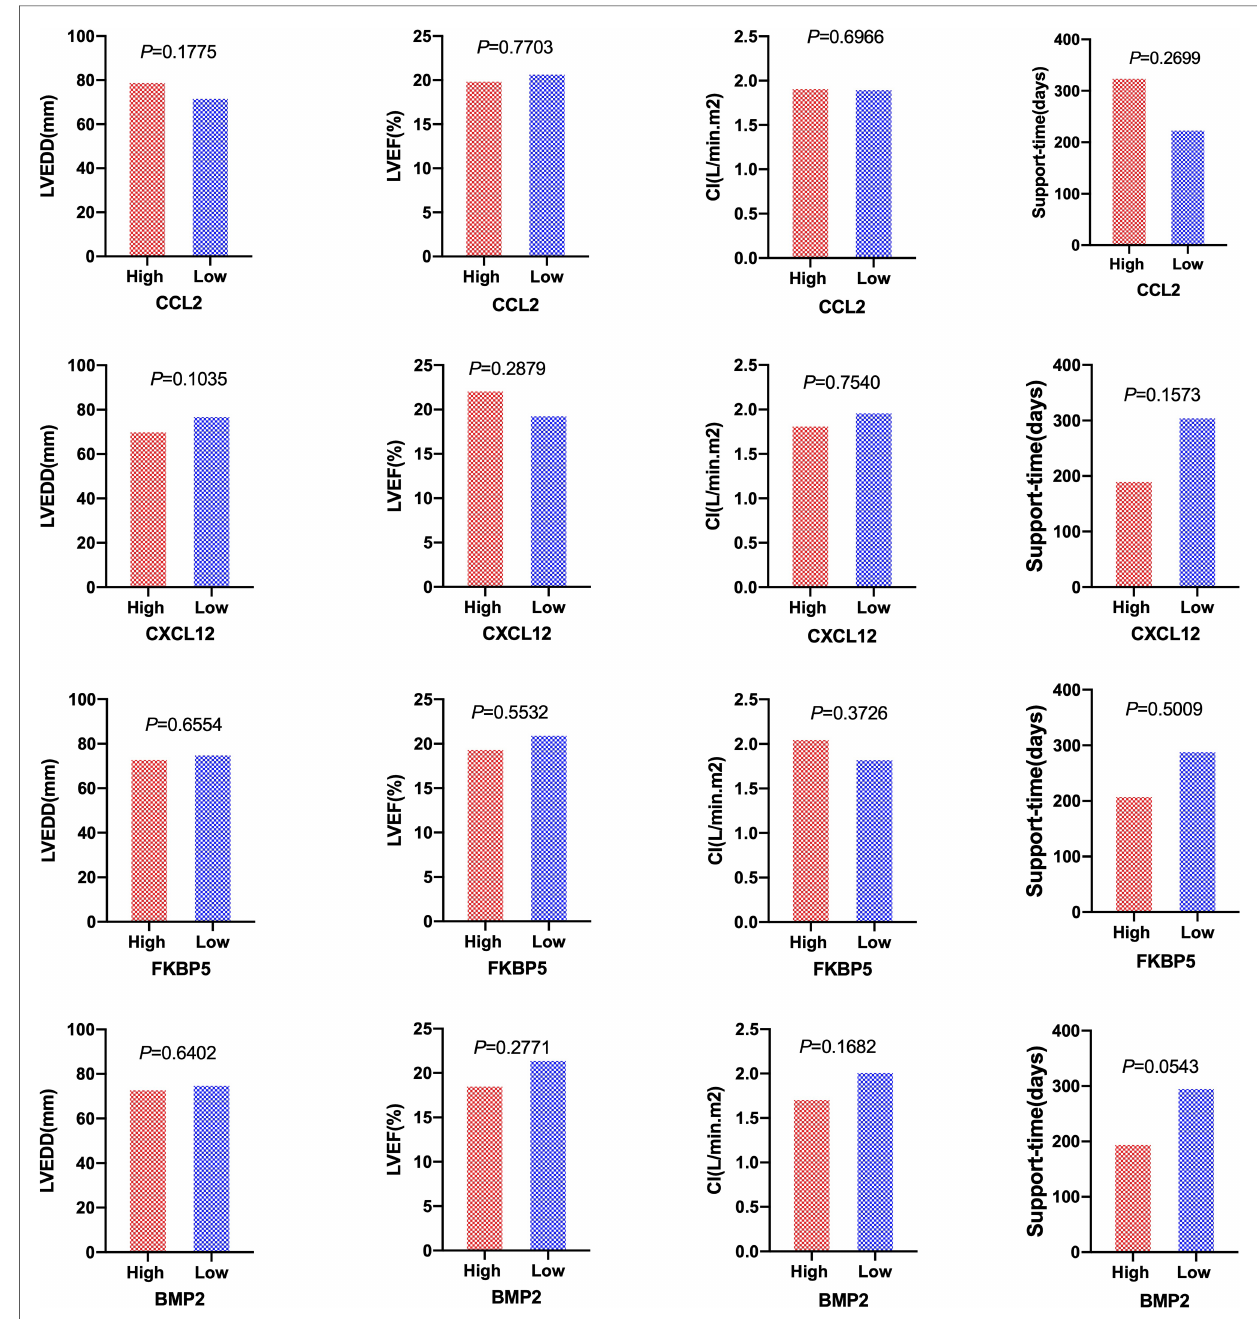
FIGURE 10 Patients of LVEDD, LVEF, CI, and the support time of LVAD between high-expression groups and low-expression groups of CCL2 , CXCL12, FKBP5 , and BMP2 hub genes. High and rRed ones represented high-expression groups. The low and blue ones represented low-expression groups. LVEDD, left ventricular end-diastolic diameter; LVEF, left ventricular ejection fraction; CI, cardiac